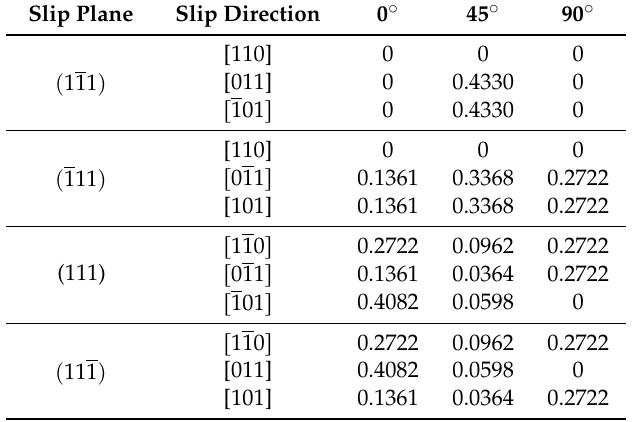
Table 2. Schmid factors of the slip system {111}<110> for various tensile orientations. Slip Plane Slip